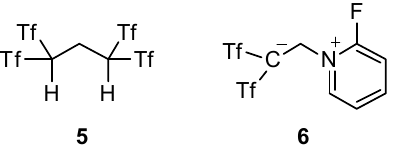
Figure 1. Structures of 1,1-bis(triflyl)ethylating